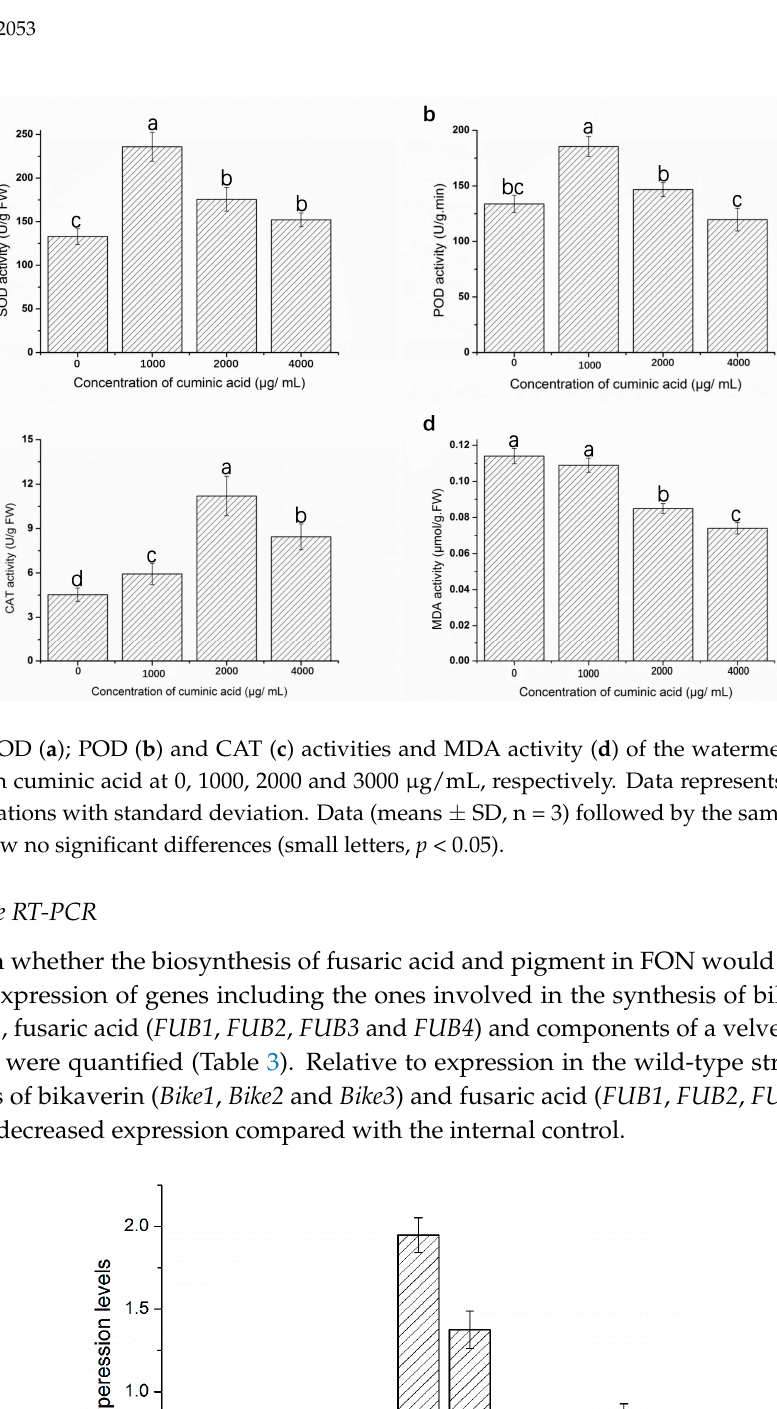
Table 3. qRT-PCR primers applied in this study.